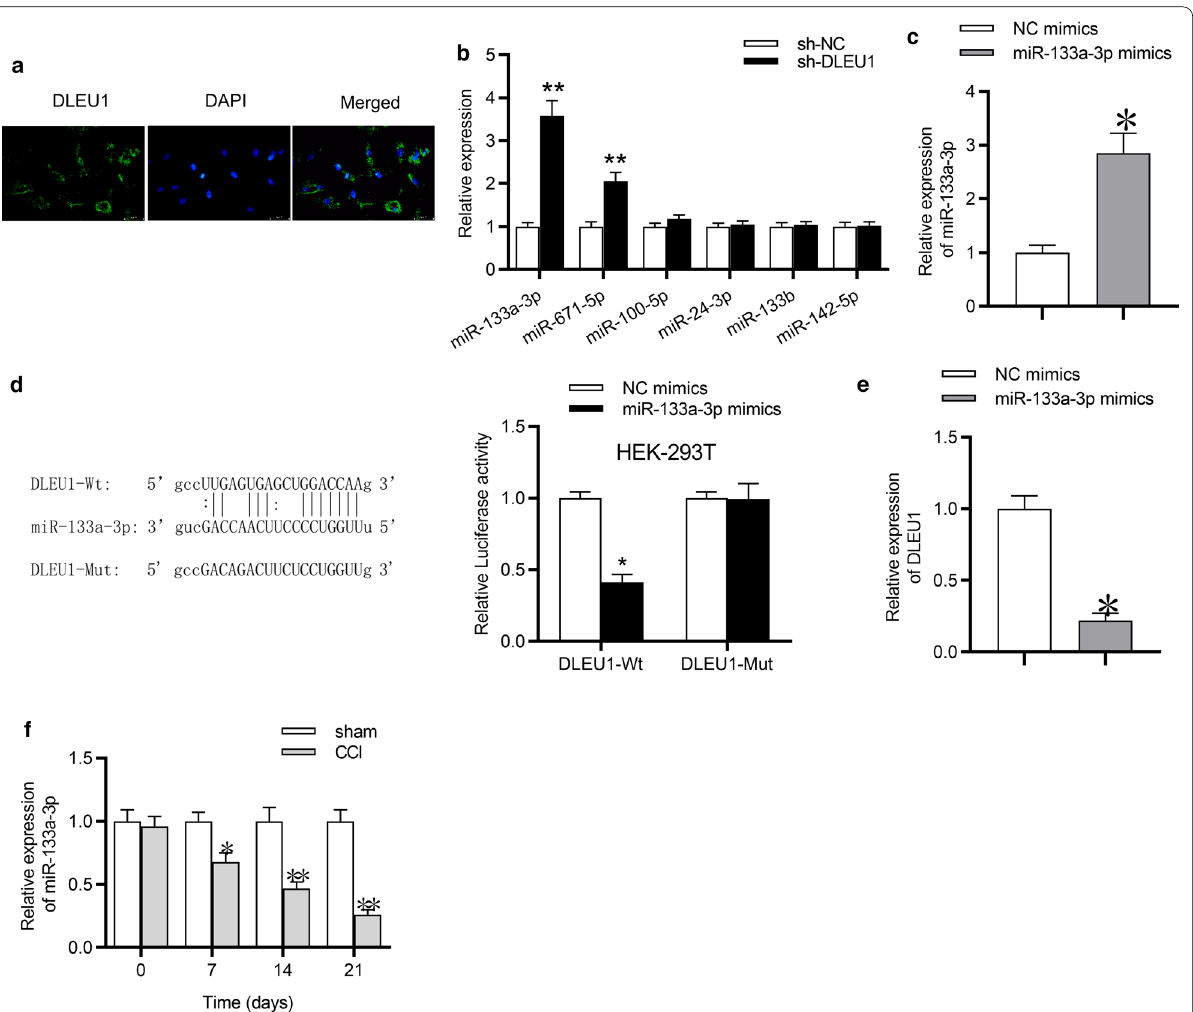
Fig. 3 DLEU1 bound with miR-133a-3p. a FISH assay was conducted to detect the DLEU1 subcellular localization in rat microglial cells. b RT-qPCR analysis was conducted to detect the relative expression of miRNAs in rat microglial cells by indicated transfections. c MiR-133a-3p expression in rat microglial cells was overexpressed by transfection with miR-133a-3p mimics and the efficiency of transfection was determined by RT-qPCR analysis. d Luciferase reporter assay was conducted to confirm the relationship between miR-133a-3p and DLEU1 in HEK-293T cells. e RT-qPCR analysis was conducted to detect the expression of DLEU1 in rat microglial cells transfected with miR-133a-3p mimics. f RT-qPCR analysis was conducted to assess the expression of miR-133a-3p in spinal cord tissues after CCI surgery for 0, 7, 14, 21 days. *p < 0.05, **p <